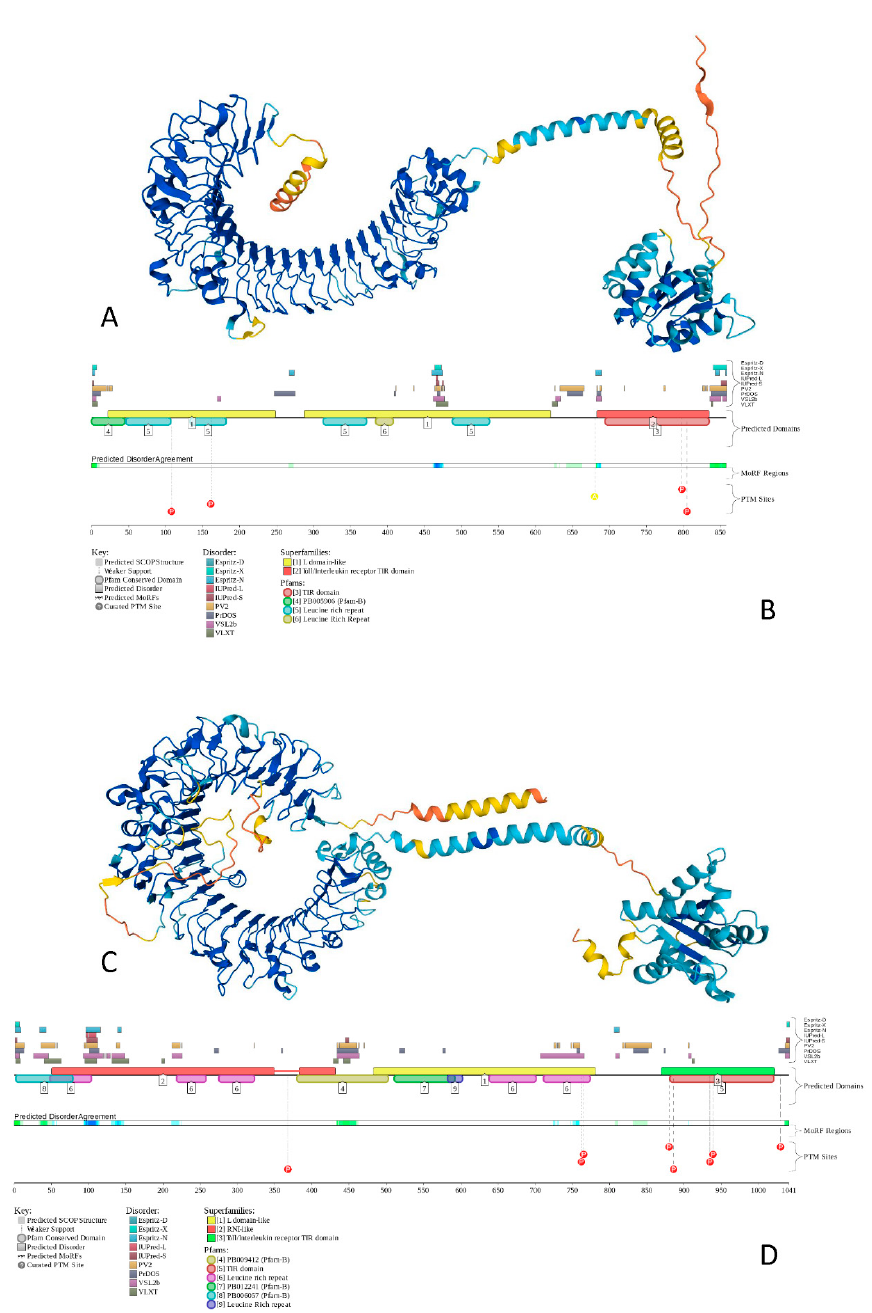
Figure 4. The structure and functional disorder of the most ordered (TLR5, plots ( A , B )) and most disordered (TLR8, plots ( C , D )) human TLRs. Structures of these proteins (plots ( A , C )) were modeled using AlphaFold [142], which is recognized now as a highly accurate tool suitable for